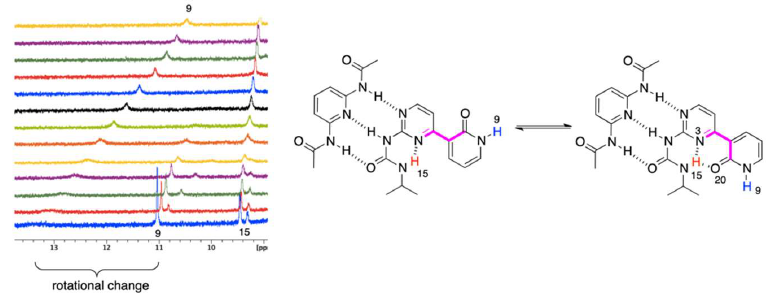
Figure 5. The VT spectra for 1 + B complex (+20 to −40 °C, from top to bottom).